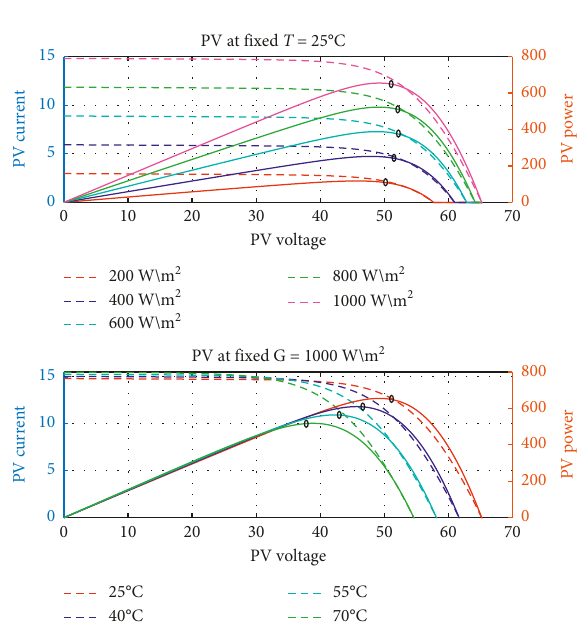
Figure 3: P-V and I-V characteristic curves at different climatic